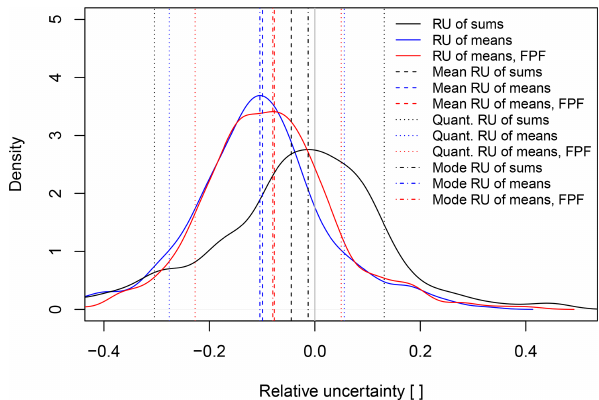
Figure 19. Probability density distributions of the relative uncer- tainty (RU) of the mean absolute vertical wind velocity, | w | , due to nonzero mean vertical wind velocity over the 30min flux in- tegration periods (blue solid line). | w | is required for the deter- mination of trace gas fluxes according to Eq. (2). The relative uncertainty of the mean vertical wind velocity was calculated as RU = ((w up −| w down | )/ 2 )/((w up +| w down | )/ 2 ) , where the over- line denotes the temporal mean of vertical wind velocity over the 30min flux integration interval, and subscripts “up” and “down” refer to updrafts and downdrafts, respectively. Results based on w from the real-time moving window planar fit coordinate rotation of the TEA system and from the fixed window post-processing planar fit rotation (FPF) are shown in blue and red, respectively. “Mean RU of means”, “Mode RU of means”, and “Quant. RU of means” indicate the mean, the mode, and the quantiles, respec- tively, for a probability of 10% and 90%. While mean vertical wind velocity | w | is needed for flux derivation, the sum of ver- tical wind velocity over the flux integration interval, P | w | , re- lates to the accumulated air sample volumes. The relative uncer- tainty of the sums, “RU of sums”, corresponds to the contribution of vertical wind velocity to the volume mismatch correction de- fined in Sect. 2. Relative uncertainty of the sum of vertical wind velocity per 30min flux integration interval was calculated as RU = (( P w up − P | w down | )/ 2 )/(( P w up + P | w down | )/ 2 ) . “Mean RU of sums”, “Mode RU of sums”, and “Quant. RU of sums” indicate the mean, the mode, and the quantiles of the distribution, respec- tively, for 10% and 90%